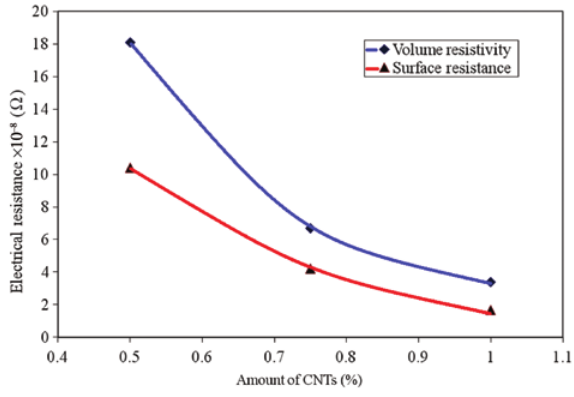
Figure 9: Electrical resistance of epoxy-CNT-OH composite with the variation of